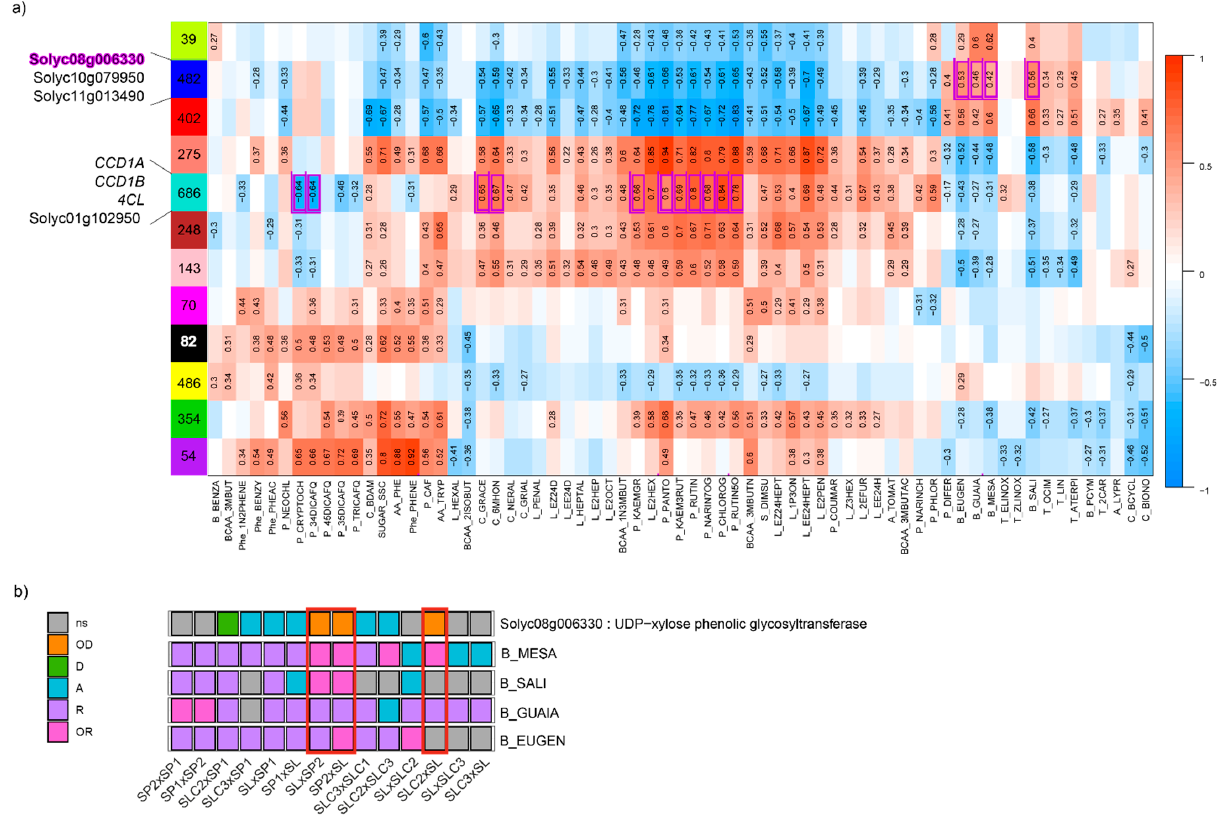
Figure 3. Integration of metabolome and transcriptome datasets by co-expression network analysis. ( a ) correlations between co-expression-modules and metabolites with the cloned (italic) and candidate genes found in co-expression modules significantly enriched in biological function linked to the synthesis of the metabolites correlated to the module. The number of differentially expressed genes (DEGs) within each module is indicated in the squares representing modules. Only significant correlations values are indicated. Positive correlations are indicated in red while negative correlations are indicated in blue; ( b ) focus on the mode of inheritance of the four benzenoid-derived VOCs (‘MESA’: methyl salicylate; ‘SALI’: salicylaldehyde; ‘GUAIA’: guaiacol; ‘EUGEN’: eugenol) in light of the mode of inheritance of the candidate gene Solyc08g006330 (coding for a glycosyltransferase). We circled in red the mode of inheritance of three crosses based on consistency between the gene and VOC modes of inheritance. Modes of inheritance are classified as over-recessive (‘OR’), recessive (‘R’), additive (‘A’), dominant (‘D’) or over-dominant (‘OD’) in a given cross. Traits or DEGs that show no significant difference (‘ns’) between at least two individuals of the cross (the two parental lines and F1 hybrids) are filled in